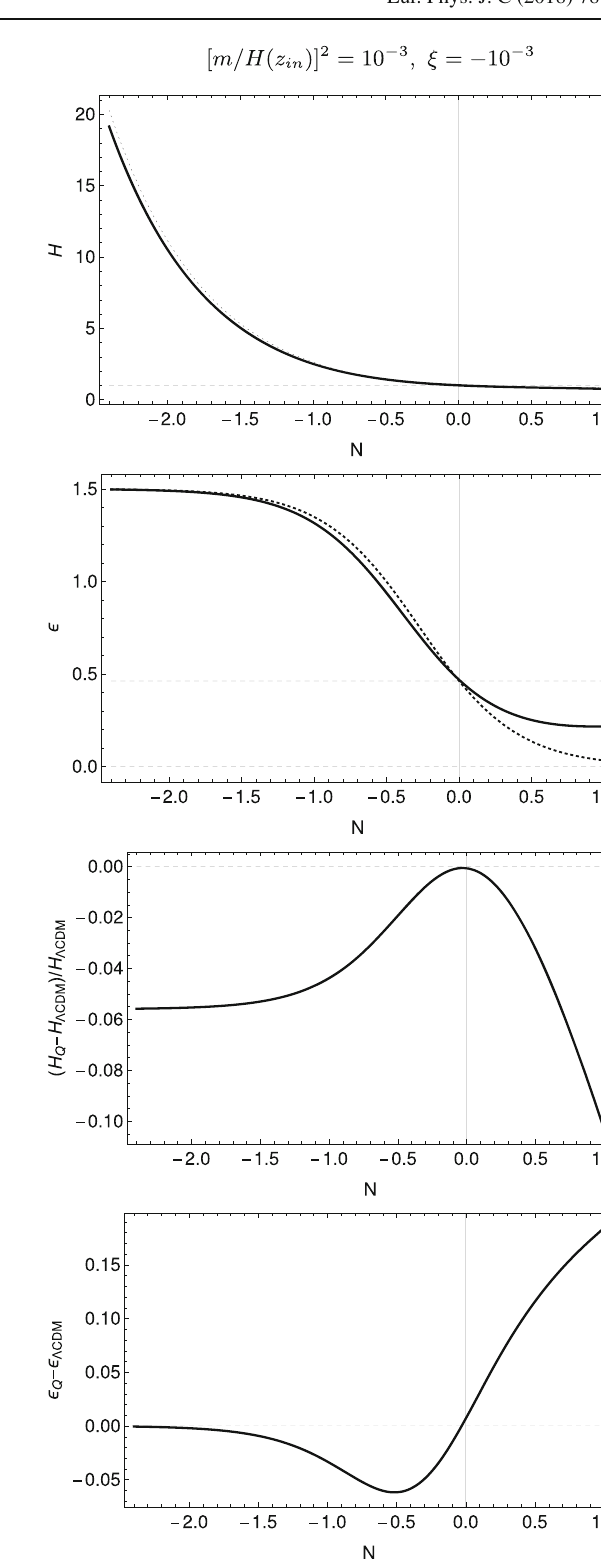
second row of the (cid:12) parameter in the backreaction model (solid line), and in the Λ CDM (dotted line). The third and fourth rows illustrate the difference between the Hubble rate and (cid:12) in the backreaction model and the Λ CDM model,